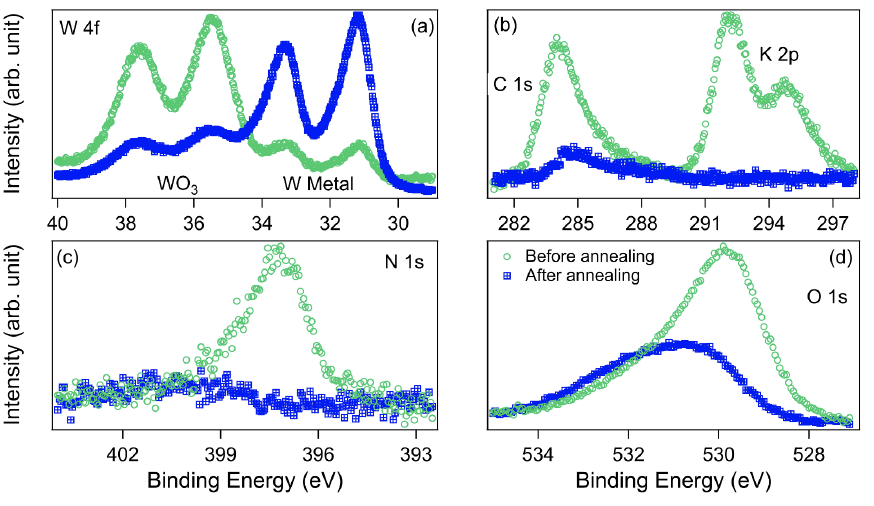
Figure 4. XPS spectra of sample W5 as a function of binding energy, showing the core levels of W 4f ( a ), C 1s and K 2p ( b ), N 1s ( c ), and O 1s ( d ) before (green open circles) and after annealing (blue